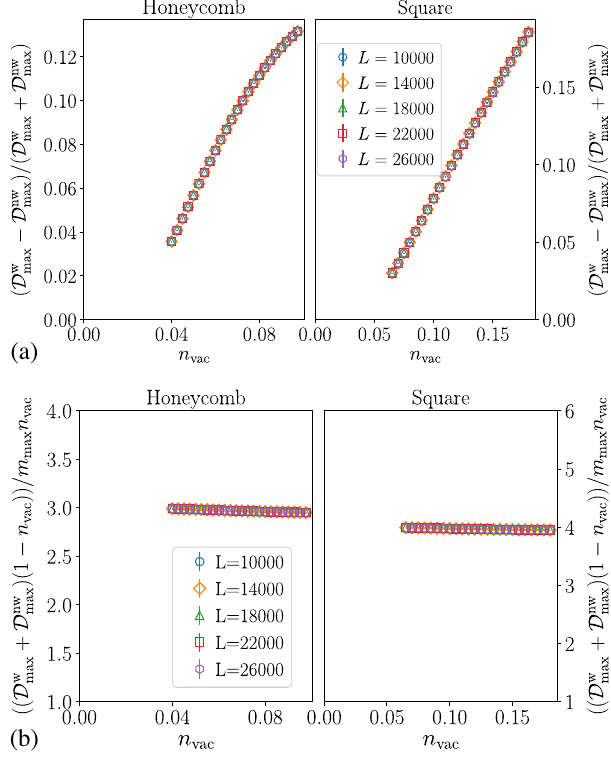
FIG. 25. (a,b) As is evident on the square and honeycomb þ lattices from the corresponding sample-averaged ratios, D nw max D w m = ð 1 − n Þ , and D nw − D w scales with n scales max max max vac max vac þ D w with D nw , again with no discernible finite-size correc- max max dependence of tions even in the low-dilution limit. The n vac ð D nw − D w Þ = ð D nw þ D w Þ broadly resembles that of max max max max I ð 1 − n Þ =wm in the low-dilution max vac max p ffiffiffiffiffiffiffiffiffiffi m scaling that would characterize a exhibiting the max truly random region of the diluted lattice. In Figs. 24